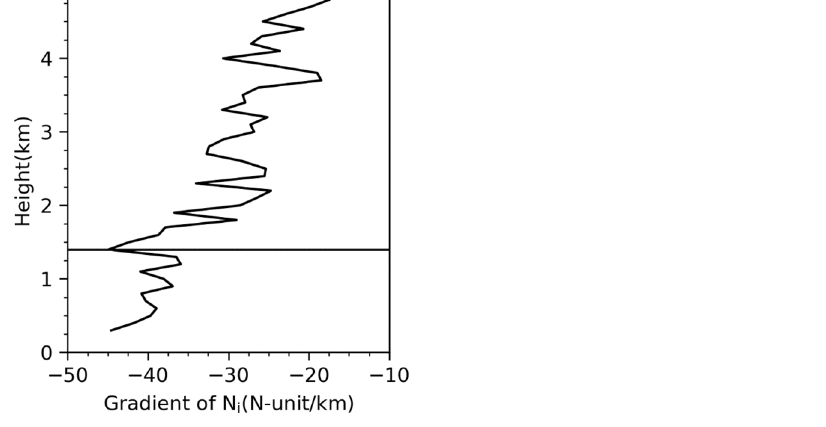
Figure 4. The N i gradient profile of RO2. The black horizontal line shows the PBLH.